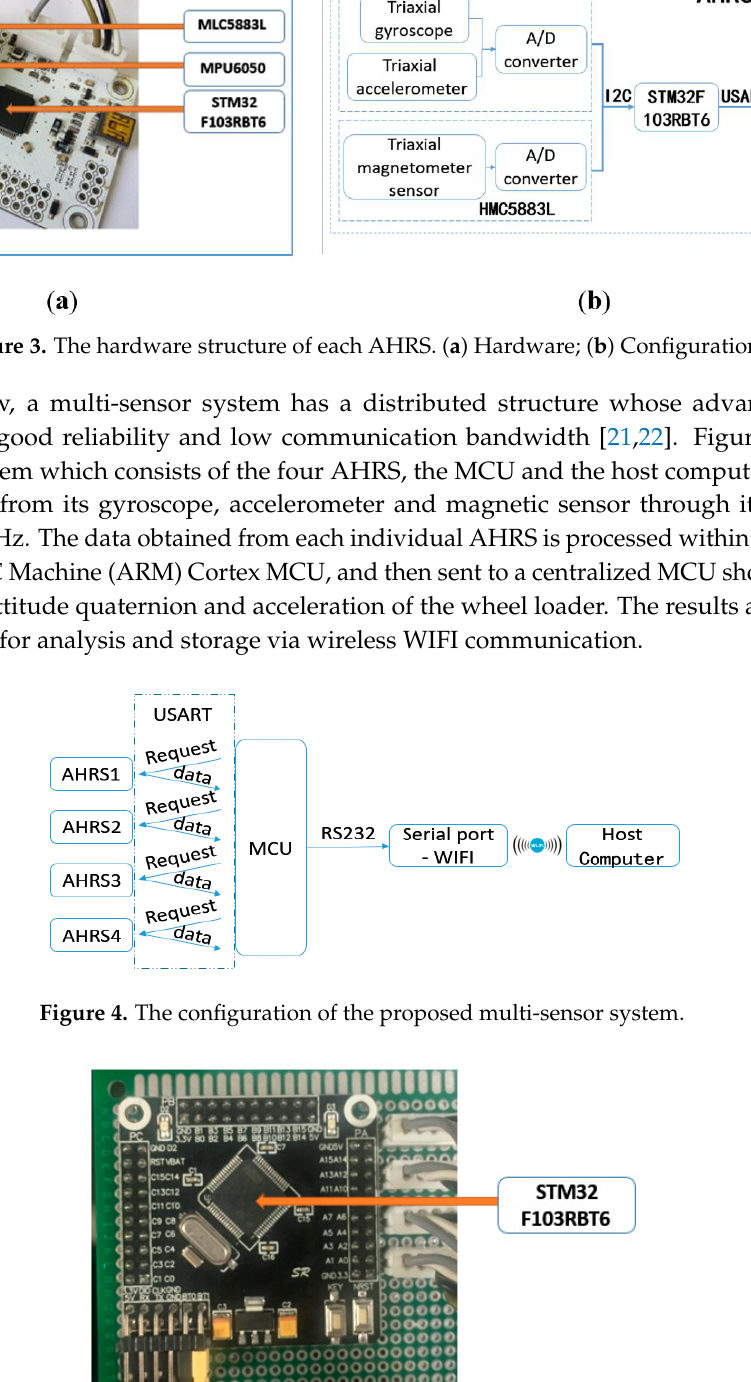
Figure 3. The hardware structure of each AHRS. ( a ) Hardware ; ( b ) Configuration .